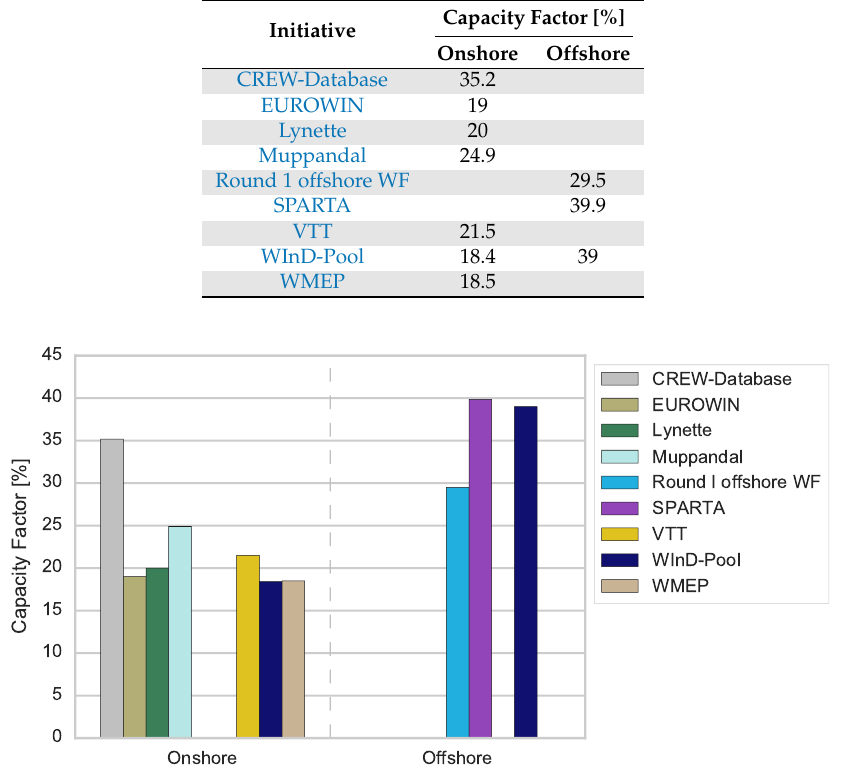
Figure 2. Capacity factors of onshore and offshore WT as published by different